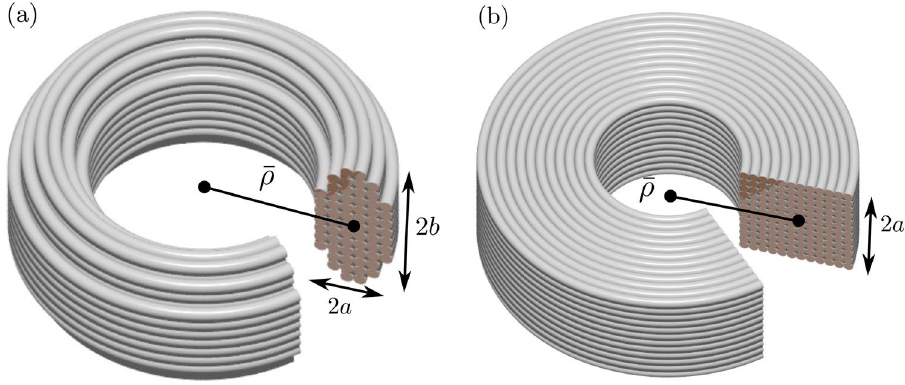
Figure 1. Schematics of multi-layer coils with ( a ) elliptic and ( b ) square